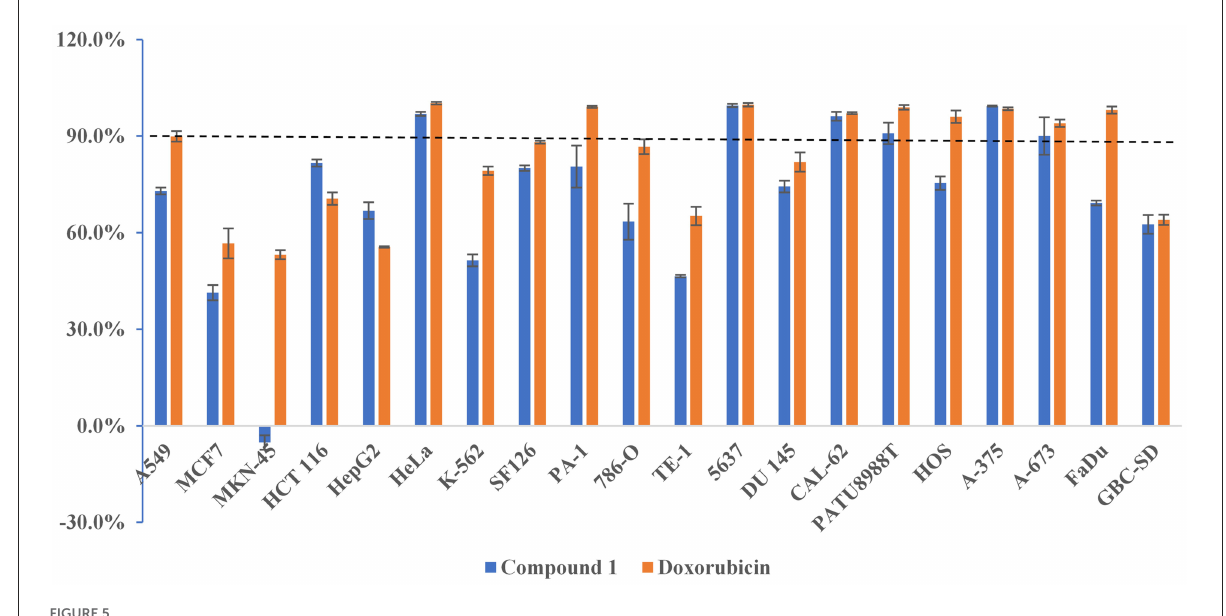
FIGURE5 Cytotoxicities of compound 1 against 20 different human tumor cell